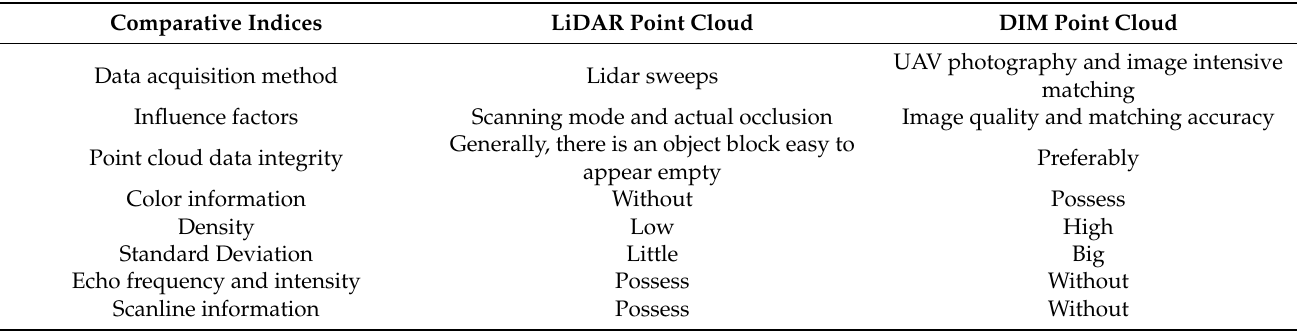
Table 1. Comparison of DIM and LiDAR point clouds.